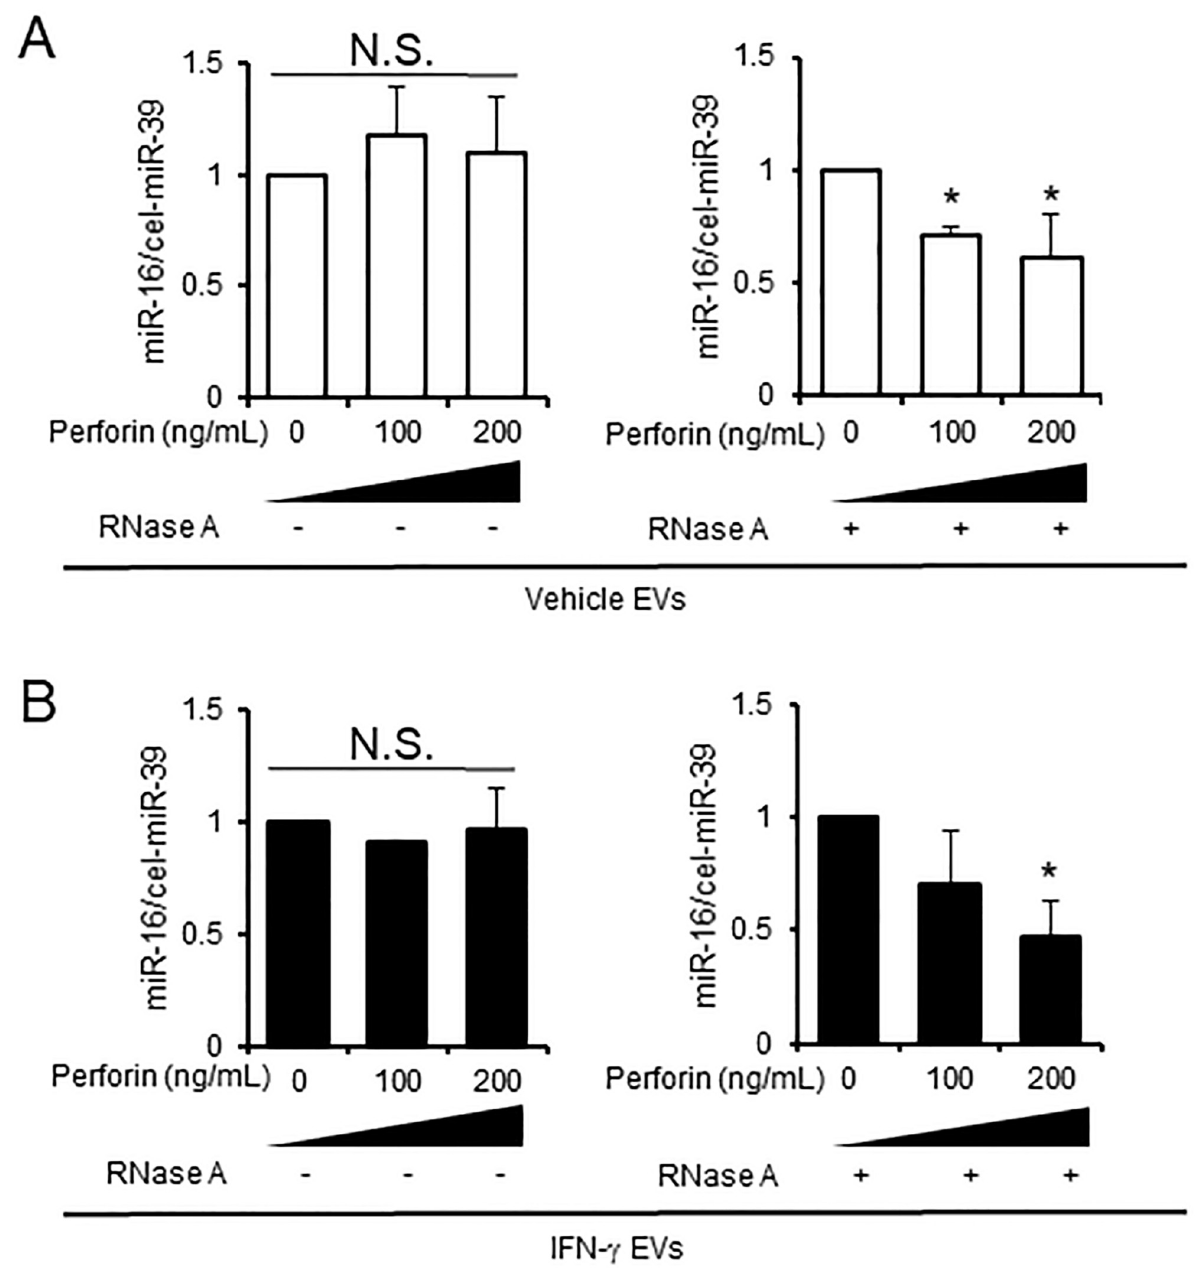
Fig 2. Measurement of the EV destruction by perforin. (A) EVs from vehicle-treated D3H2LN cells (vehicle EVs). (B) EVs from IFN- γ -treated D3H2LN cells (IFN- γ EVs). Both types of EV were treated with or without perforin, and miRNAs were degraded by RNase A (right panels). MiRNA degradation was measured by real-time PCR; cel-miR-39 was used as a spike-in control. P < 0.05 (Tukey–Kramer method). All experiments were performed using three biological replicates, and each sample was compared with individual controls; thus the control has no standard